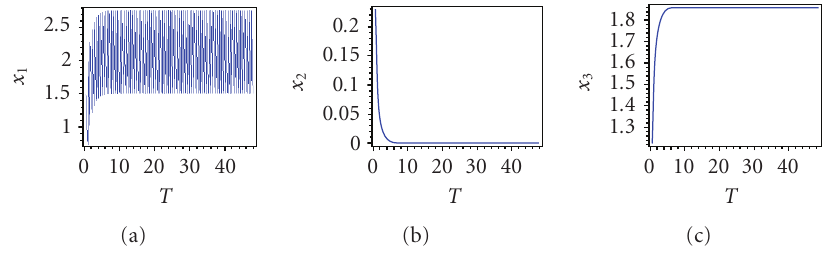
Figure 5.1. Extinct of system (1.2): (a) time series of the nutrient, (b) time series of the microorgan- ism, (c) time series of the toxicant in the organism, p = 1 . 25, q = 1 . 86, T = 0 .